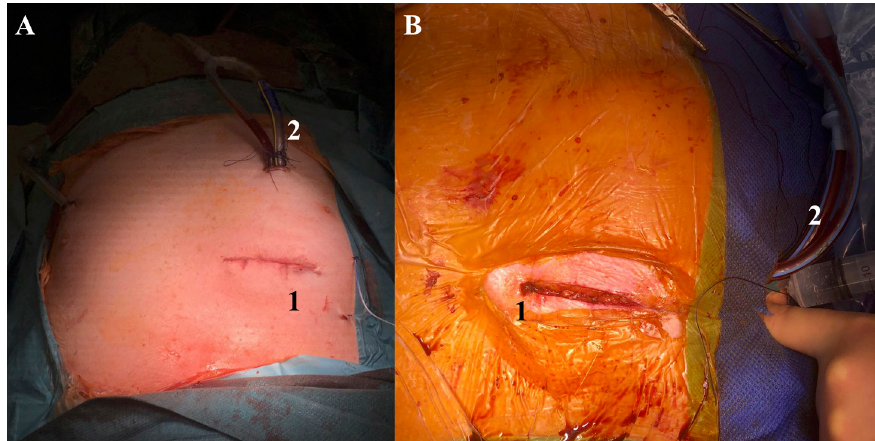
Fig. 3 - Cosmetic result of minimally invasive aortic valve replacement via right anterior thoracotomy approach. A) 1, 5-cm incision; 2, chest tube; B) 1, 5-cm incision; 2, chest